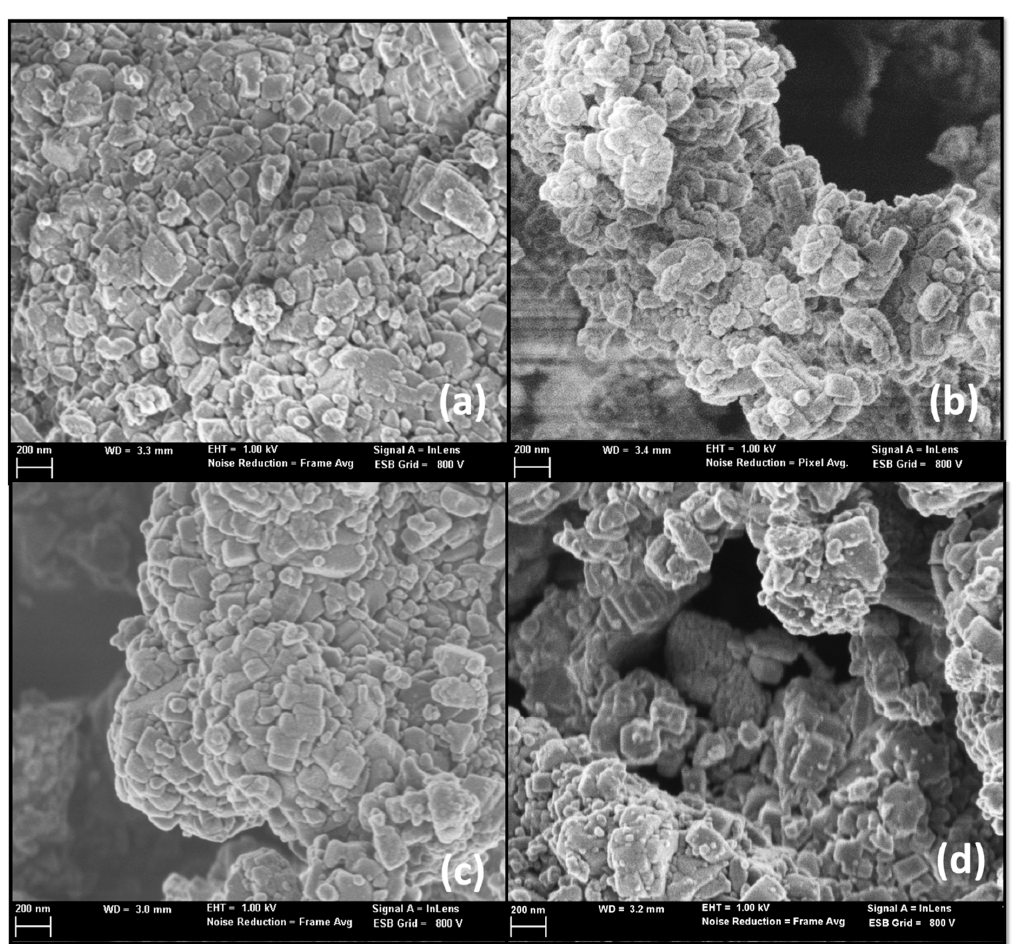
Figure 3. FE-SEM micrographs of ( a ) Fe-Cu-Z, ( b ) Fe-Cu-Zag, ( c ) W-Fe-Cu-Z, and ( d ) W-Fe-Cu-Zag catalysts.